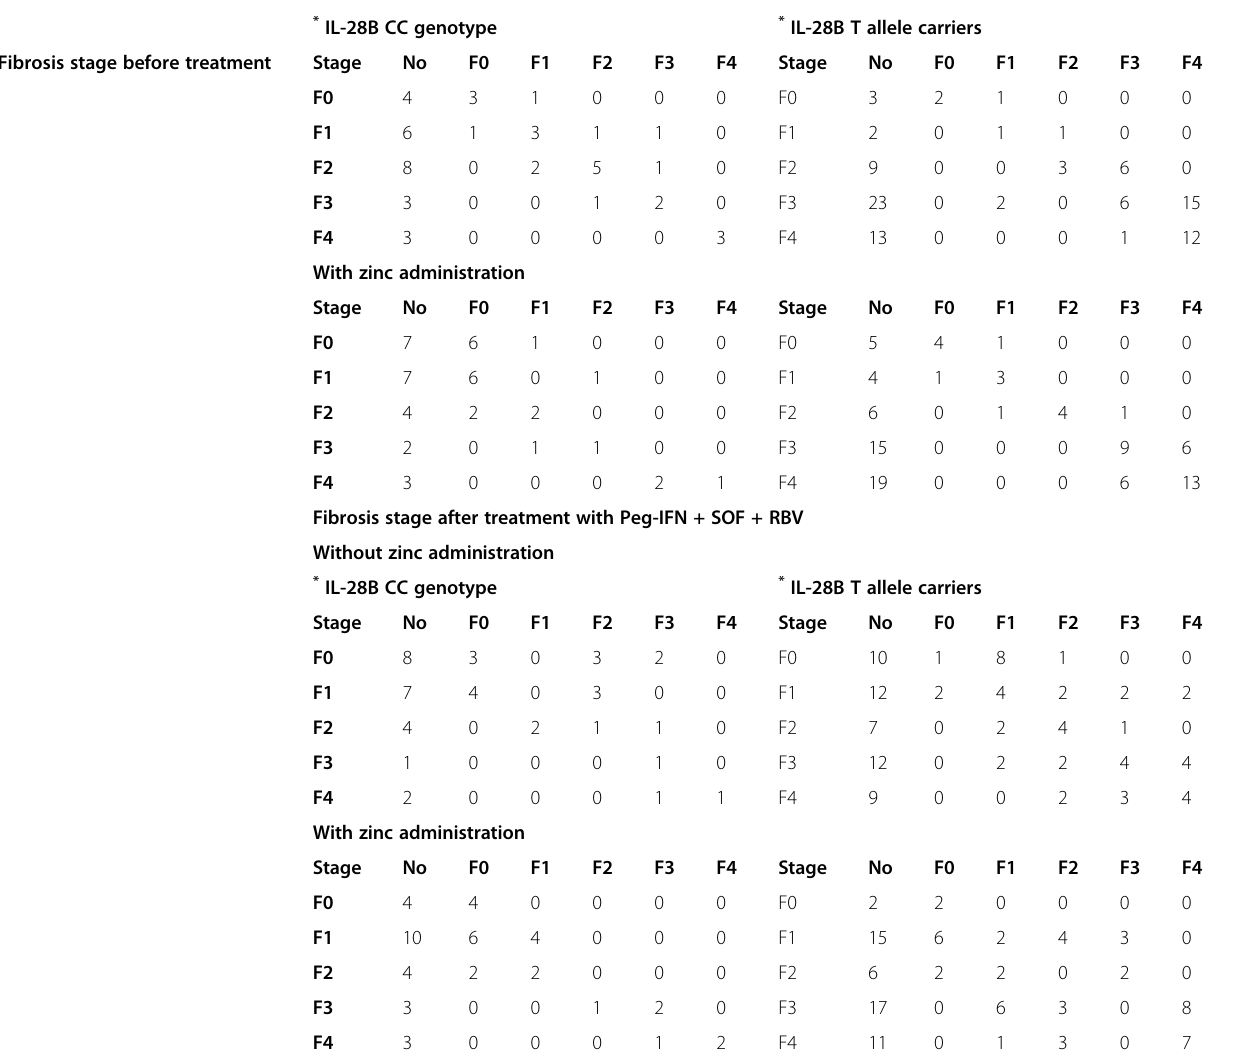
Table 2 The change in fibrosis grades before and after HCV treatments according to FibroScan Fibrosis stage after treatment with SOF + RBV Without zinc administration * IL-28B CC genotype * IL-28B T allele carriers Fibrosis stage before